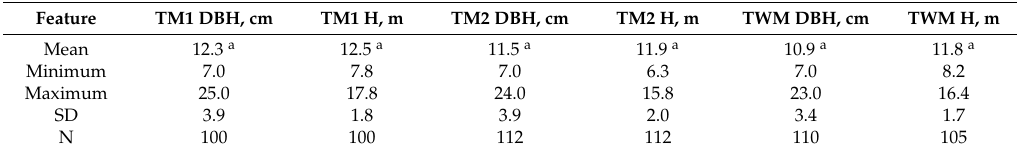
Table 2. Characteristics of trees selected for thinning